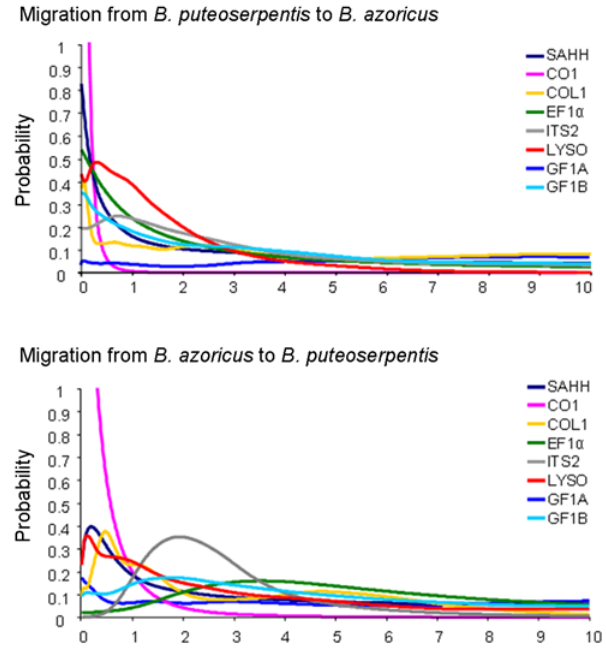
Figure 8. IMa single locus probability distributions of migra- tion rates for each of the 8